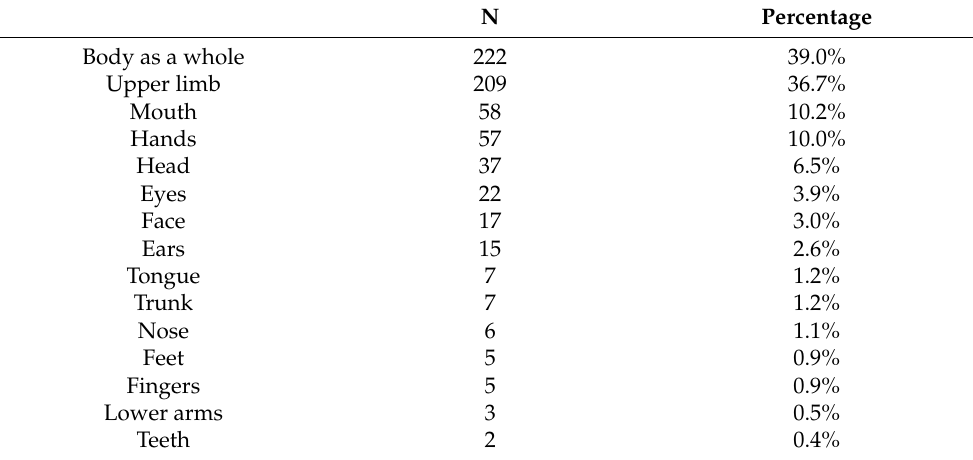
Table 3. Body parts involved in motor stereotypies.